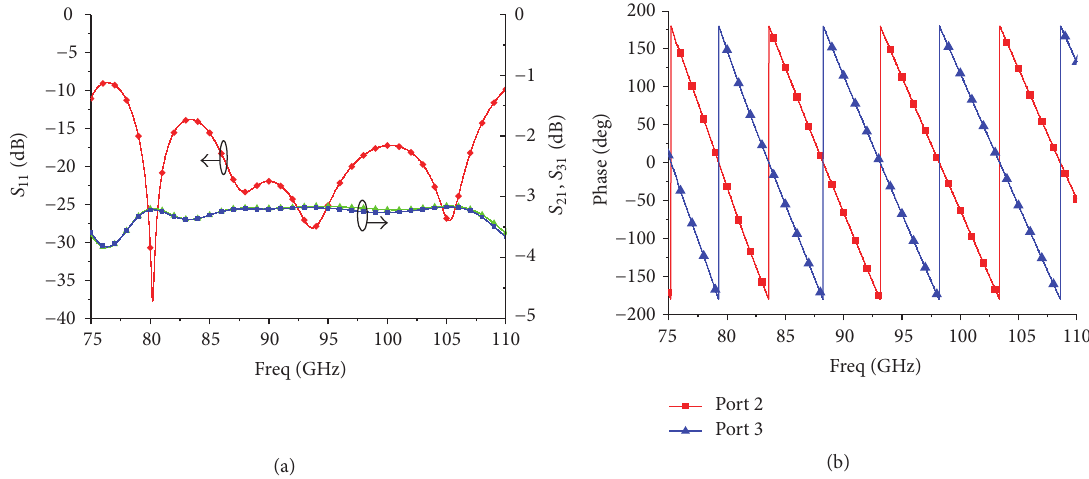
Figure 3: (a) 𝑆 -parameters of the proposed hybrid waveguide-SIW E-plane divider; (b) phase output of the proposed hybrid waveguide-SIW E-plane